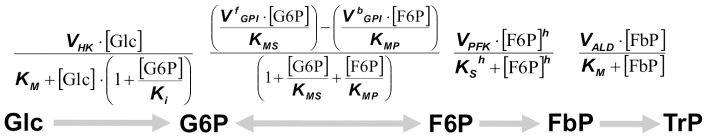
Scheme of the kinetic model.The scheme, equations and parameter values correspond to the kinetic model published previously [25]. Parameters for HK: KM = 0.40 mM, Ki = 0.11 mM. Parameters for GPI: VfGPI = 12474 nmol mg prot−1 min−1, VbGPI = 18125 nmol mg prot−1 min−1, KMS = 0.48 mM, KMP = 0.27 mM. Parameters for PFK: KS = 0.061 mM, h = 1.47. Parameters for ALD: VALD = 6000 nmol mg prot−1 min−1, KM = 0.13 mM. Limiting rates for HK (VHK) and PFK (VPFK) decrease at increasing values for Hg2+ and Cd2+ following equations (1) and (2), respectively for Hg2+ and Cd2+, with V0HK = 63.0 nmol mg prot−1 min−1 and V0PFK = 434 nmol mg prot−1 min−1.